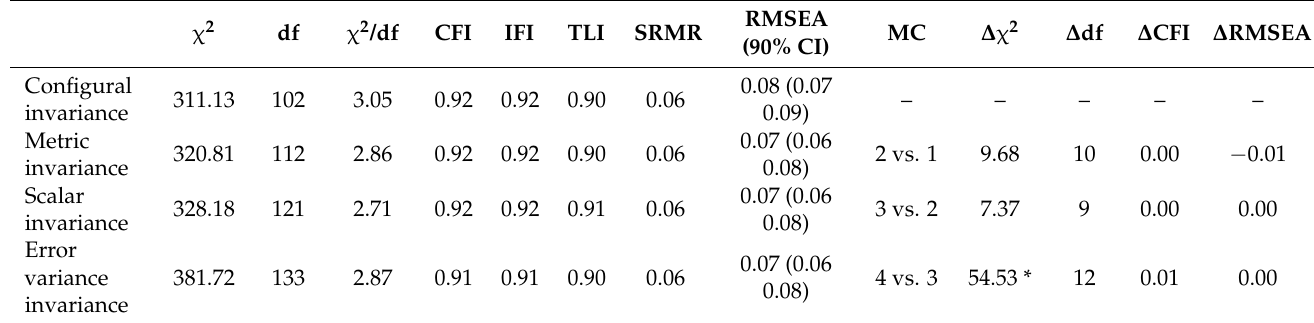
Table 2. Multi-group factor analysis of